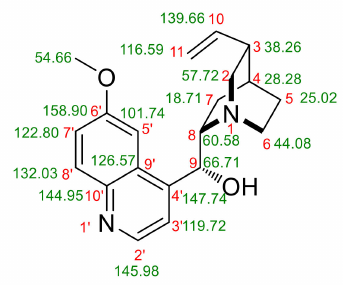
Figure 1. Chemical structure of quinine. The red numbers represent the atom numbering while the green numbers represent the 13C NMR chemical shift